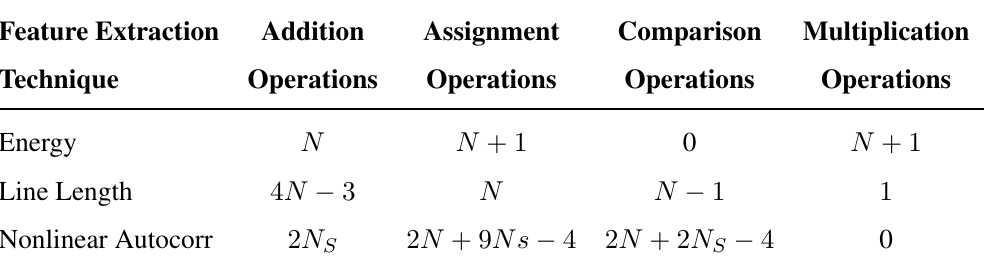
Table 4. Number of operations performed by each feature extraction technique. Nonlinear Autocorr, nonlinear